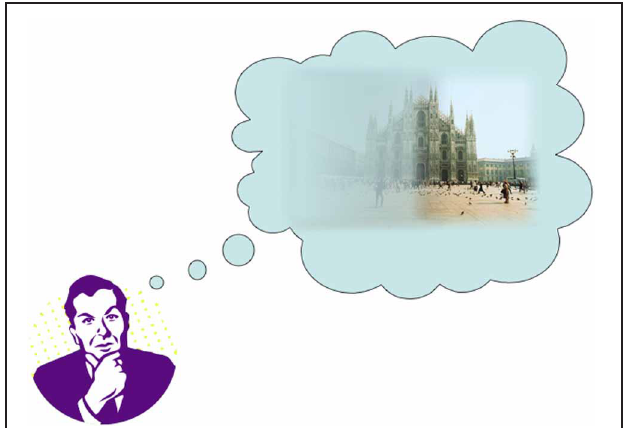
FIGURE 4 | Imaginal neglect. In their seminal paper, Bisiach and Luzzatti (1978) reported two left neglect patients who, when asked to imagine and describe from memory familiar surroundings (the Piazza del Duomo in Milan), omitted to mention left-sided details regardless of the imaginary vantage point that they